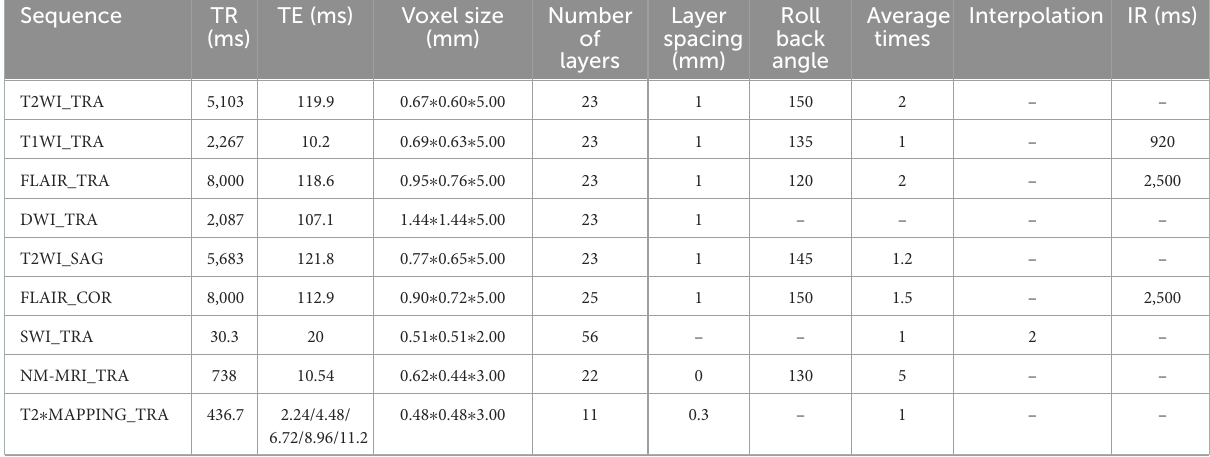
TABLE 1 Scan each sequence parameter